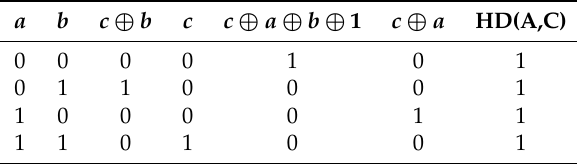
Table 5. HD( E 1 ( a ) , E 1 ( a ) ∧ E 2 ( b ) ) of Step. (1) in Table